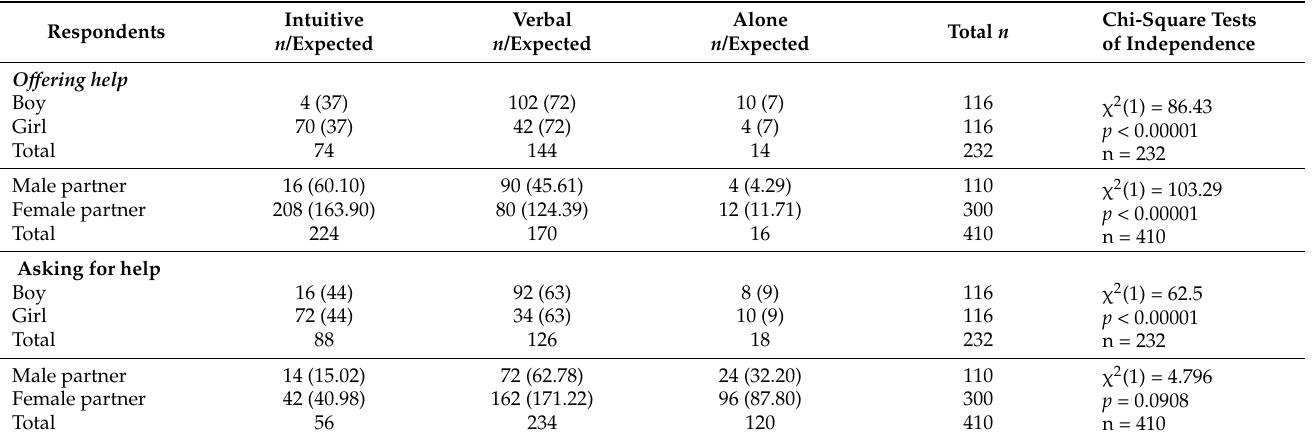
Table 2. Comparisons of females and males in the intuitive and verbal condition of asking for or offering help.